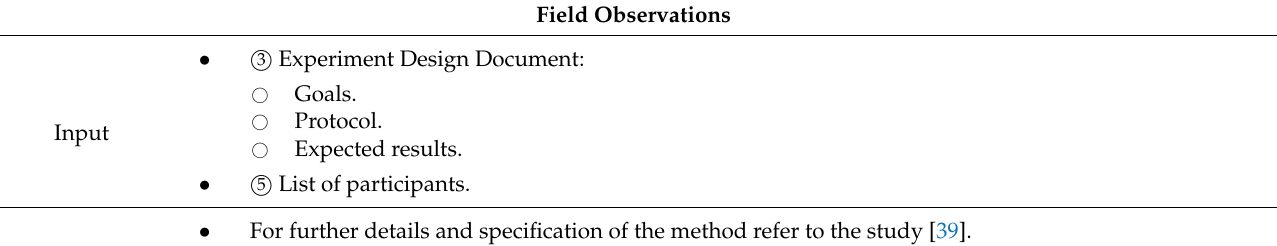
Table A12. Field Observations Specification. Field Observations